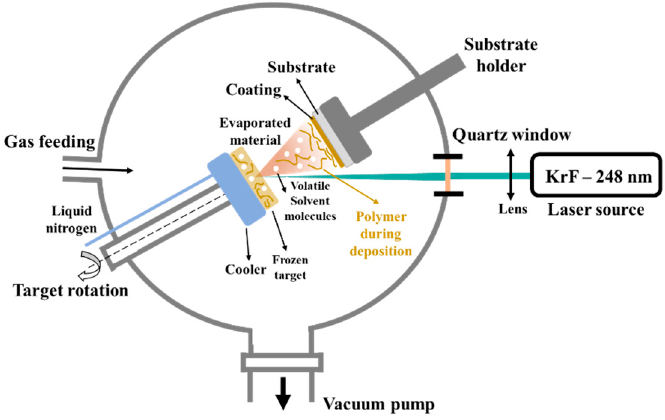
Figure 2. Schematic representation of MAPLE experimental setup.